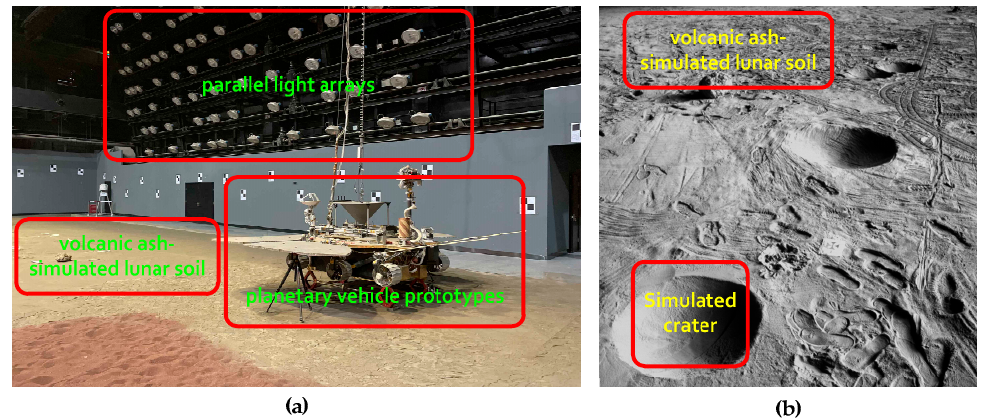
Figure 12. ( a ) Is the overall environment of the test site, including parallel light arrays, simulated lunar soil and planetary vehicle prototypes. ( b ) Is the image taken by the navigation camera after turning on the parallel light array in the test field.